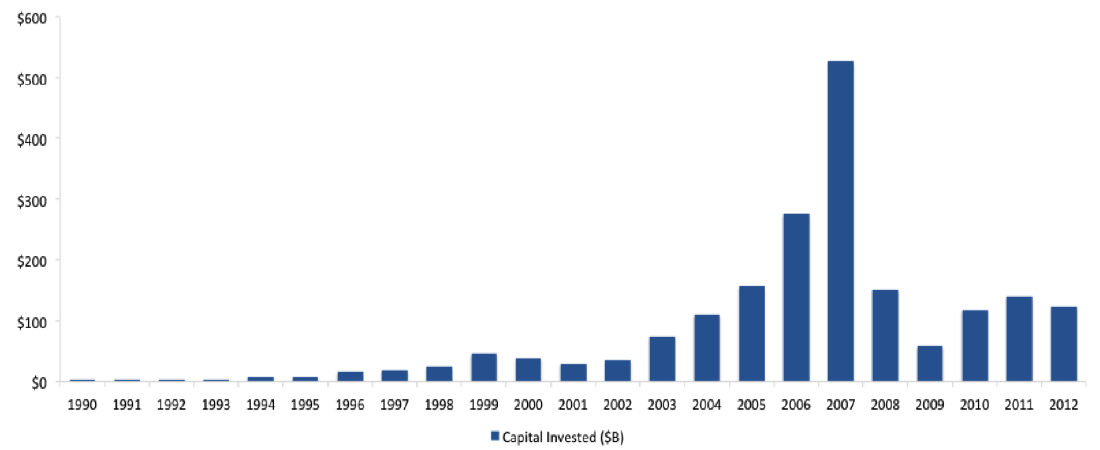
Figure 1: Aggregate LBO Deal Value by Year market participants that this period constituted a bubble of historic proportions.